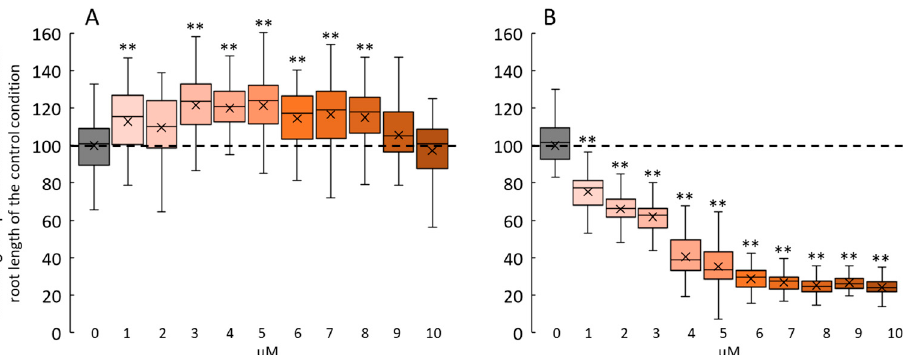
Figure 4. Dose response of 2F-Fuc-NB and photoreleased 1-OH-2F-Fuc on Arabidopsis root growth after 7 days. ( A ): Changes in root length in 7-day-old Arabidopsis cultivated in a medium supple- mented with 0 to 10 µM of 2F-Fuc-NB without photolysis. ( B ): Effect of photoreleased 1-OH-2F-Fuc from 2F-Fuc-NB on 7-day-old roots after 10 min of irradiation at 365 nm at day 3. Dashed lines in A and B represent the mean root length in the control conditions. ** indicates statistical differences from the control condition ( p < 0.01).